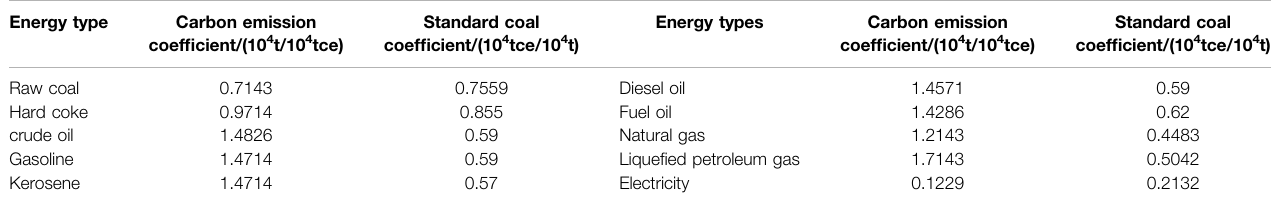
TABLE 2 | Standard coal conversion factors and carbon emission factors for various energy